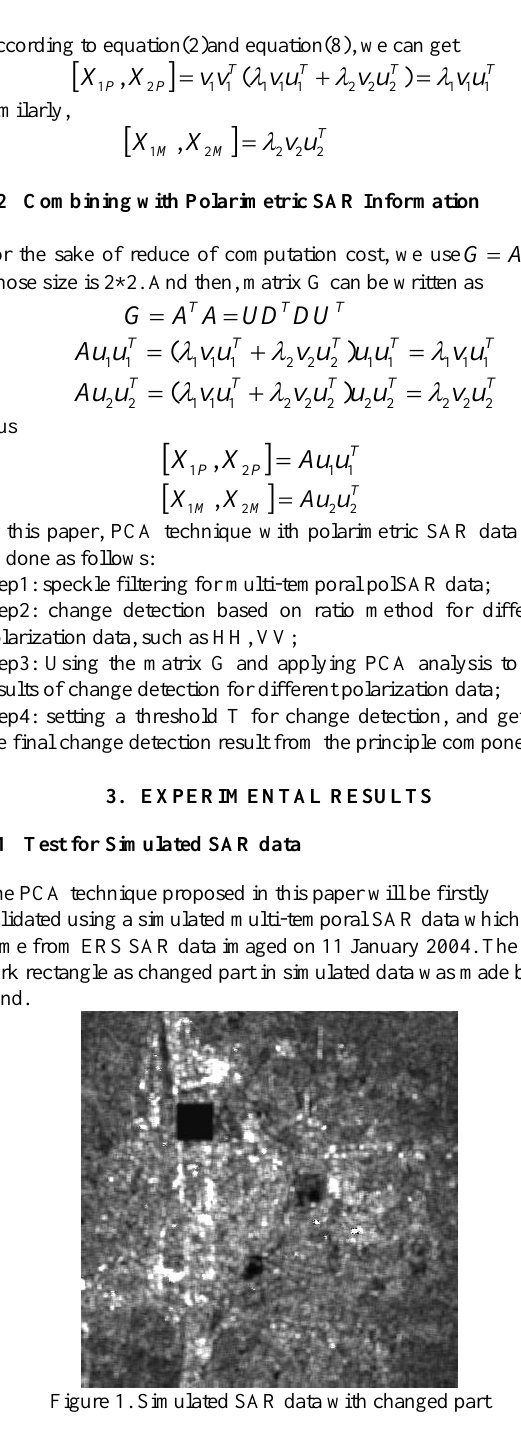
Figure 1. Simulated SAR data with changed part